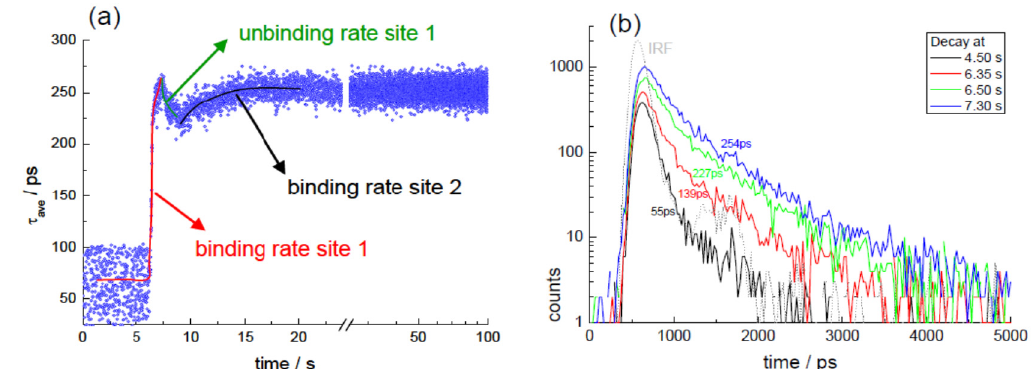
Figure 12. Binding of turmeric extract with serum albumin; ( a ) outcome of a two exponential analysis from a kinetic TSCPC dataset. 10,000 decay histograms were collected, each with an acquisition time of 10 ms; ( b ) representative decay histograms at different times at the beginning of the binding process. Adapted from